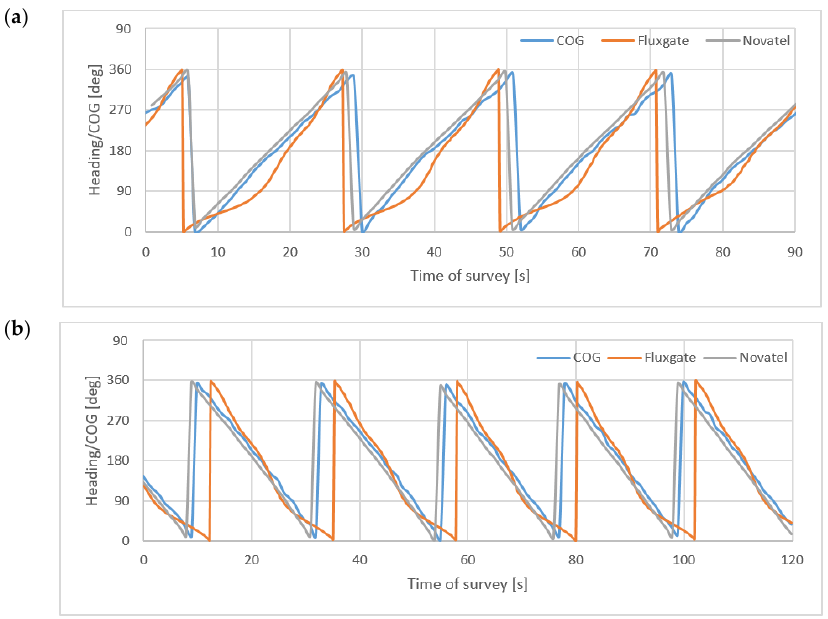
Figure 13. Headings and COG during 90 s rotation of the USV to the right ( a ) and 120 s rotation to the left ( b ).